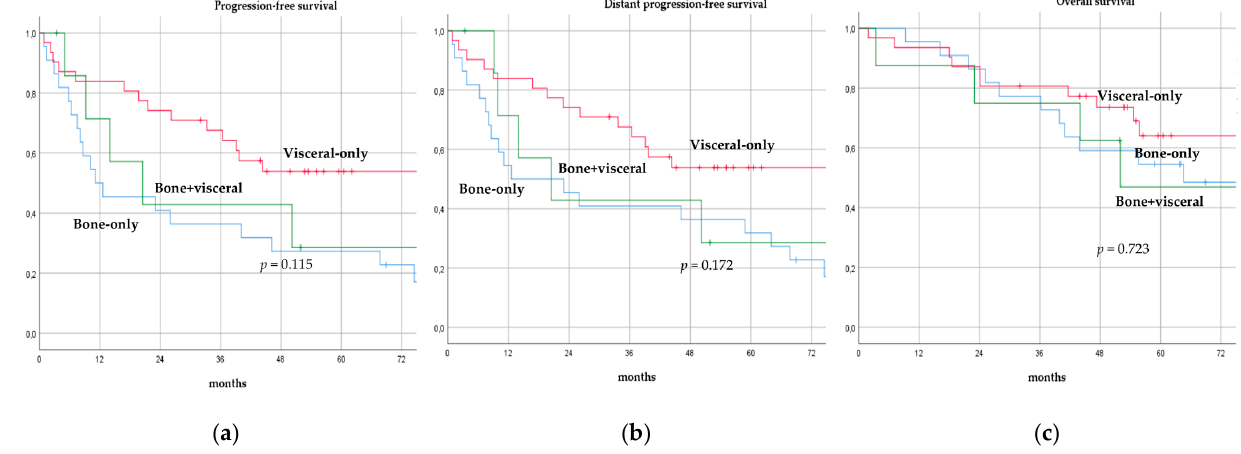
Figure 2. Progression-free survival ( a ), distant progression-free survival ( b ), and overall survival ( c ) curves of de novo metastatic breast cancer patients according to location of metastases.